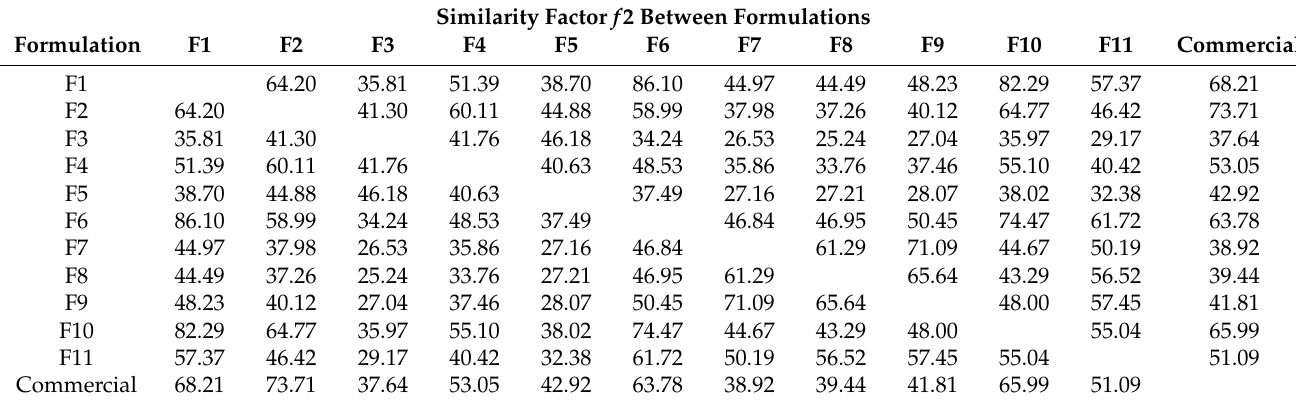
Table 7. AMH SD oral immediate ‐ release tablets characteristics similarity f 2 factor matrix. Similarity Factor f 2 Between Formulations